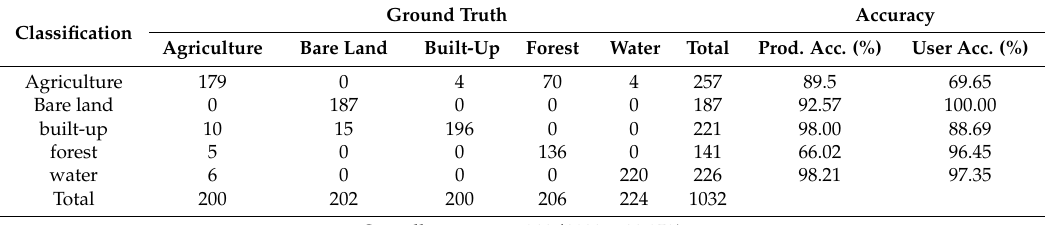
Table 3. Error matrix of the unsupervised